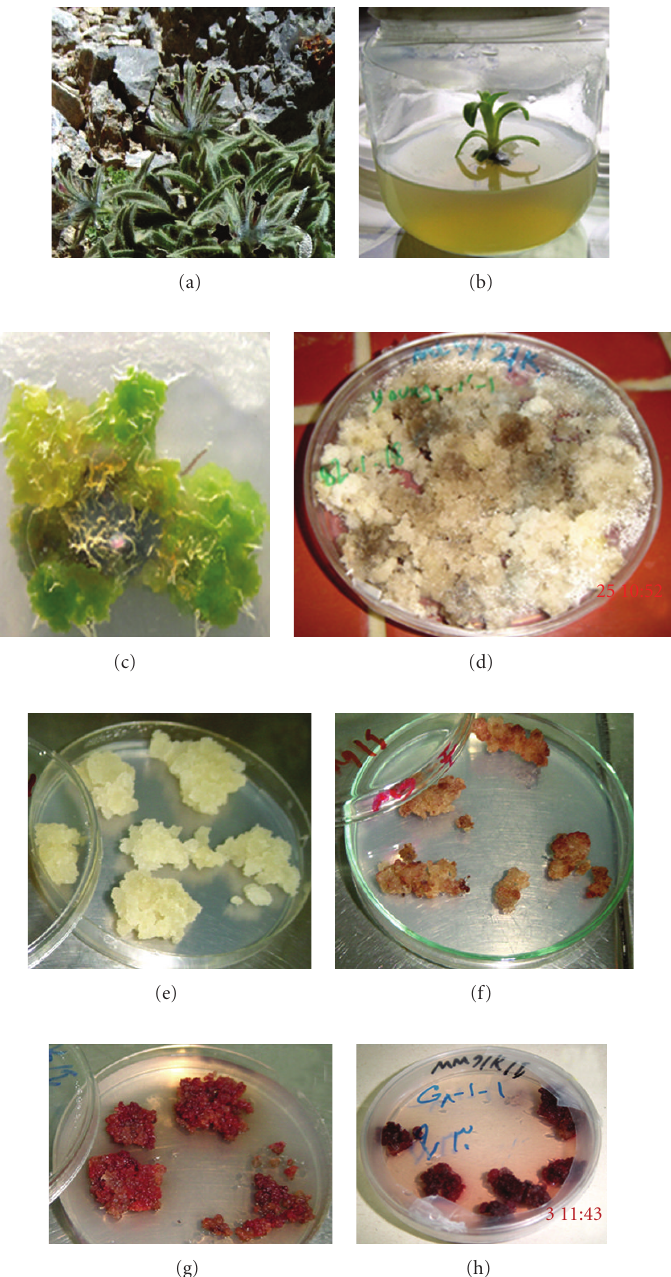
Figure 2: (a) A. euchroma found in central Zagross altitudes locally called Ho’e-Cho’e, (b) A young A. euchroma plantlet on hormone-free MS medium, (c) A. euchroma callus subcultured on LS medium containing 2,4-D in the light, (d) A. euchroma callus subcultured in the dark on a modified LS medium ([NH 4 NO 3 ] = 16.5, [KNO 3 ] = 1900 mg/L) containing 2,4-D, (e) A. euchroma callus subcultured in the dark on mLS medium ([NH 4 NO 3 ] = 0, [KNO 3 ] = 2850) containing 2,4-D, (f) A. euchroma callus subcultured in the dark on LS medium containing IAA, (g) A. euchroma callus subcultured in the dark on White medium containing IAA, (h) A. euchroma callus subcultured in the dark on mM9 medium containing IAA. The auxin concentration in experiments 2C-2H was adjusted to 10 − 6 M and the corresponding media contained kinetin (10 − 5